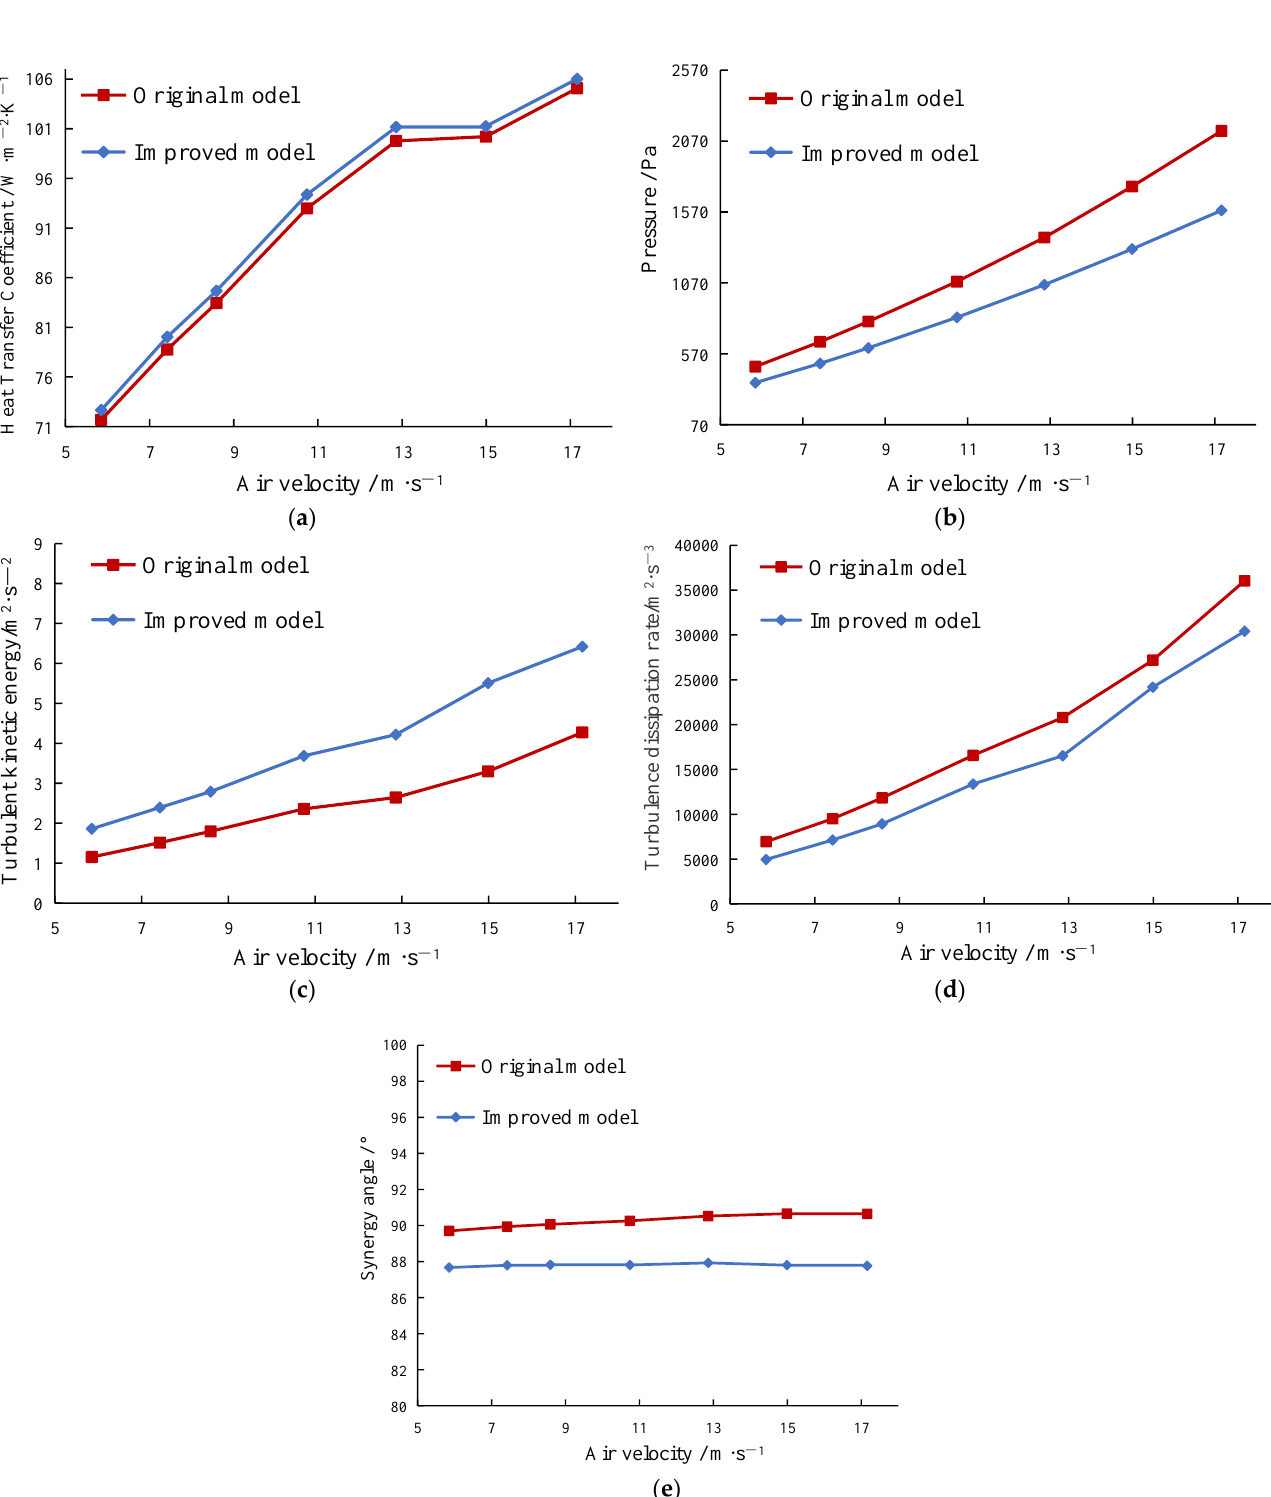
Figure 9. Comparison of performance before and after improvement; ( a ) heat transfer coefficient comparison; ( b ) pressure comparison; ( c ) turbulent kinetic energy comparison; ( d ) comparison of turbulence dissipation rate; ( e ) comparison of the law of synergy angle change.